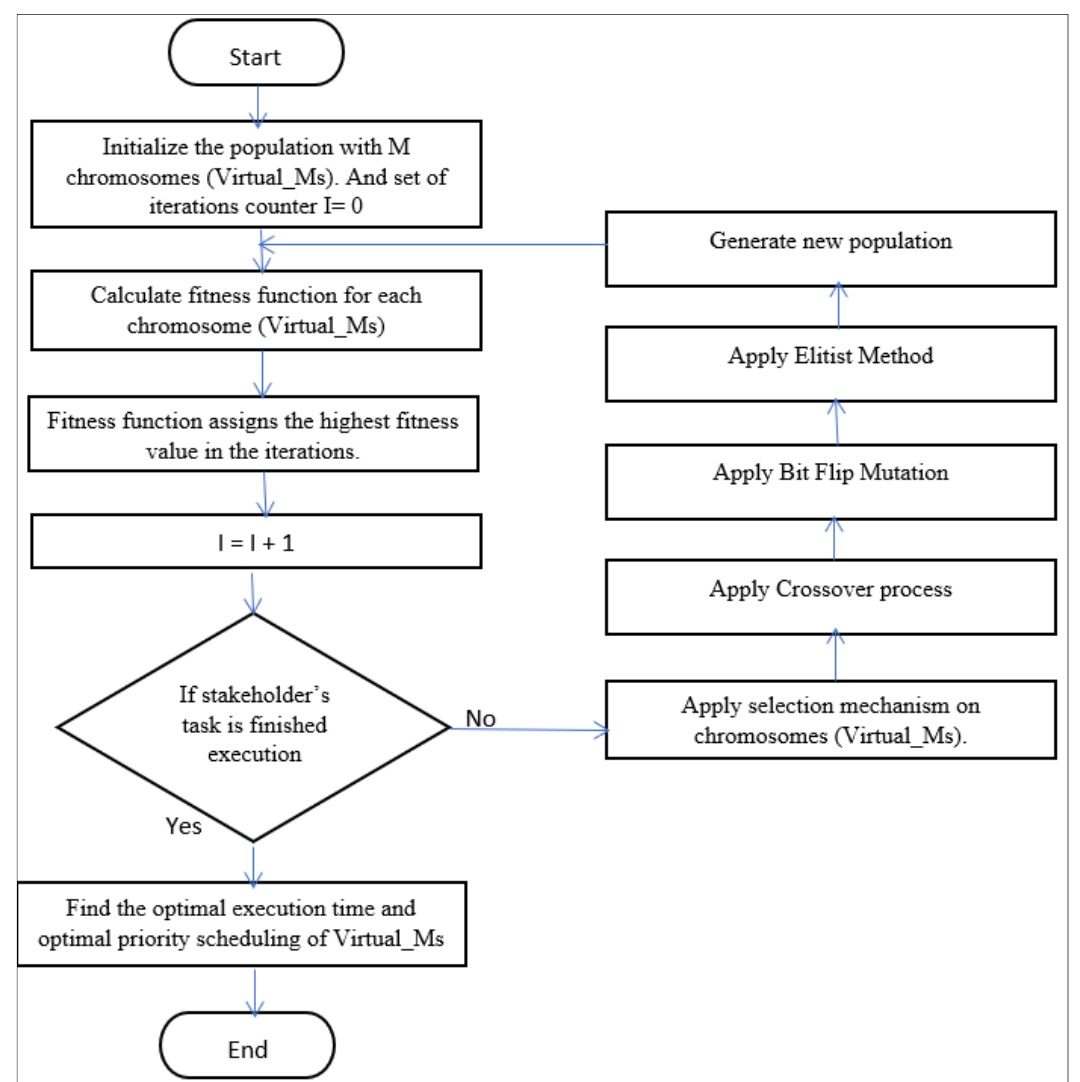
Figure 2. The proposed GA for cloud computing.